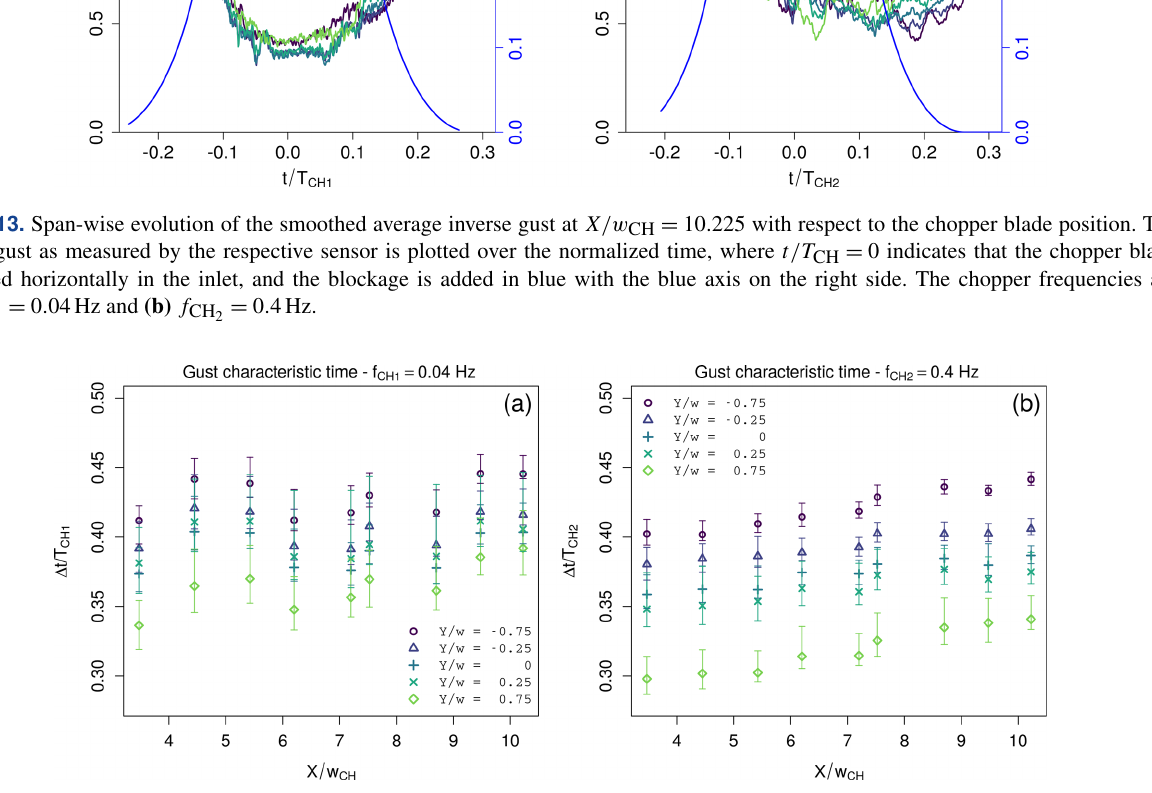
Figure 14. Average normalized characteristic time (cid:49)t/T CH of the gusts at the respective span-wise and downstream positions for (a) f CH = 0 . 0 . 04Hz and (b) f CH 2